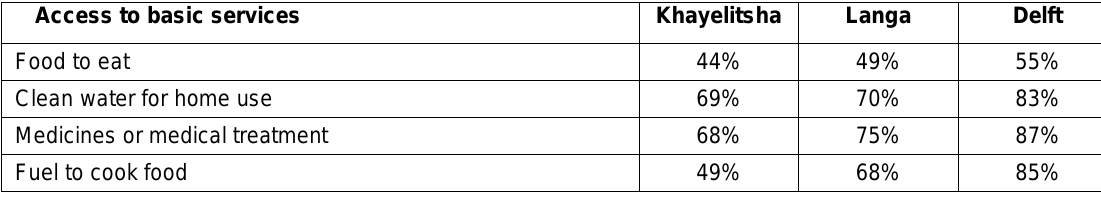
Table 1. Household health and food